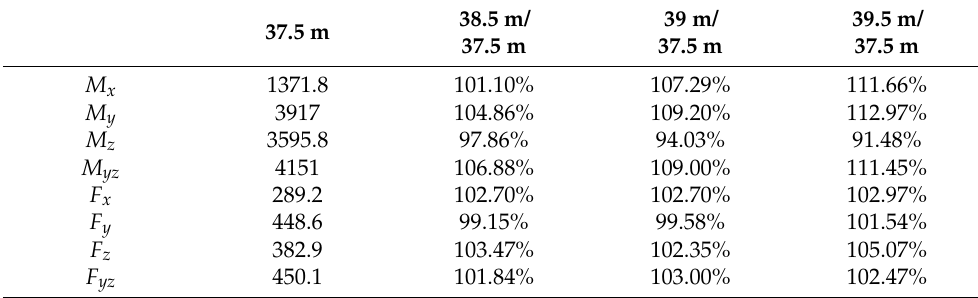
Table 9. Ultimate loads at hub.